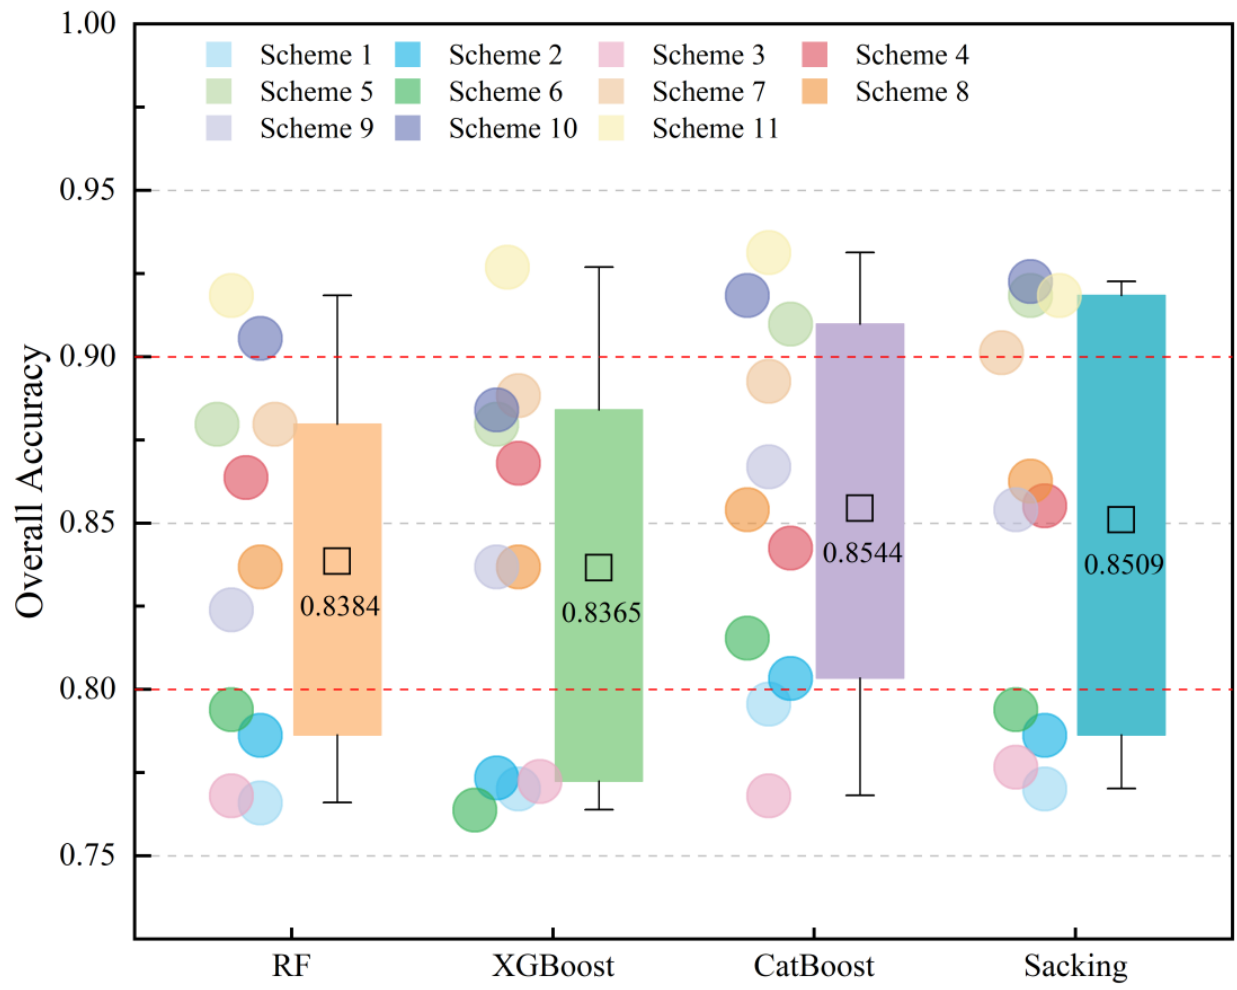
Figure 7. Overall accuracy distribution of all schemes based on four classification models.